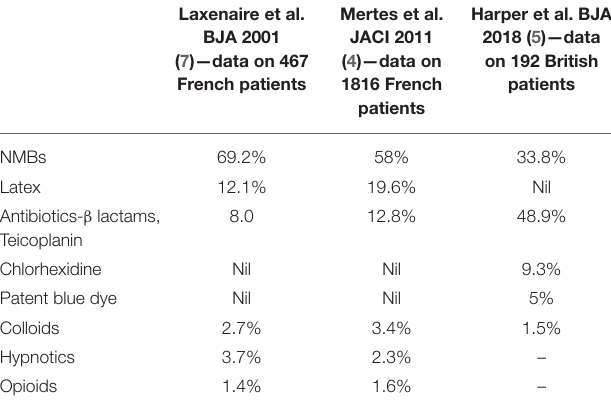
TABLE 1 | Etiology of peri-operative anaphylaxis—changing epidemiology. Laxenaire et al. BJA 2001 (7)—data on 467 French